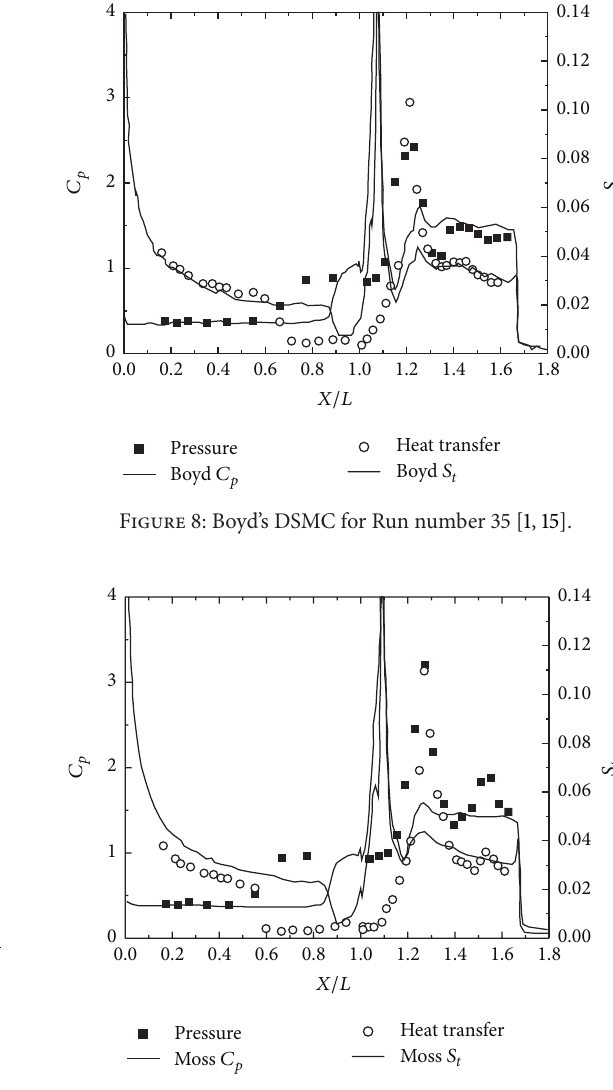
Figure 9: Moss’s DSMC for Run number 28